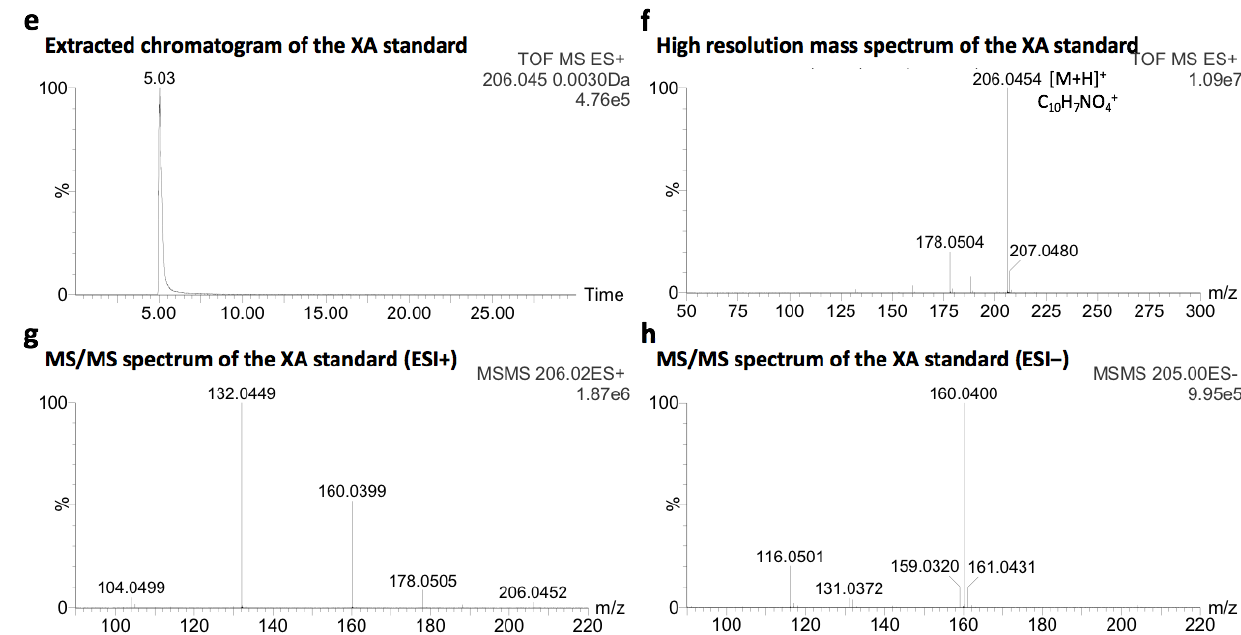
Figure 1. ( a , b ) Extracted chromatogram and high resolution mass spectrum of XA identified in PF, respectively; ( c , d ) MS/MS fragmentation spectra of XA identified in PF, in positive (ESI+) and negative (ESI−) ionization mode, respectively; ( e , f ) Extracted chromatogram and high resolution mass spectrum of the XA commercial standard, respectively; ( g , h ) MS/MS fragmentation spectra of the XA commercial standard, in positive (ESI+) and negative (ESI−) ionization mode, respectively.